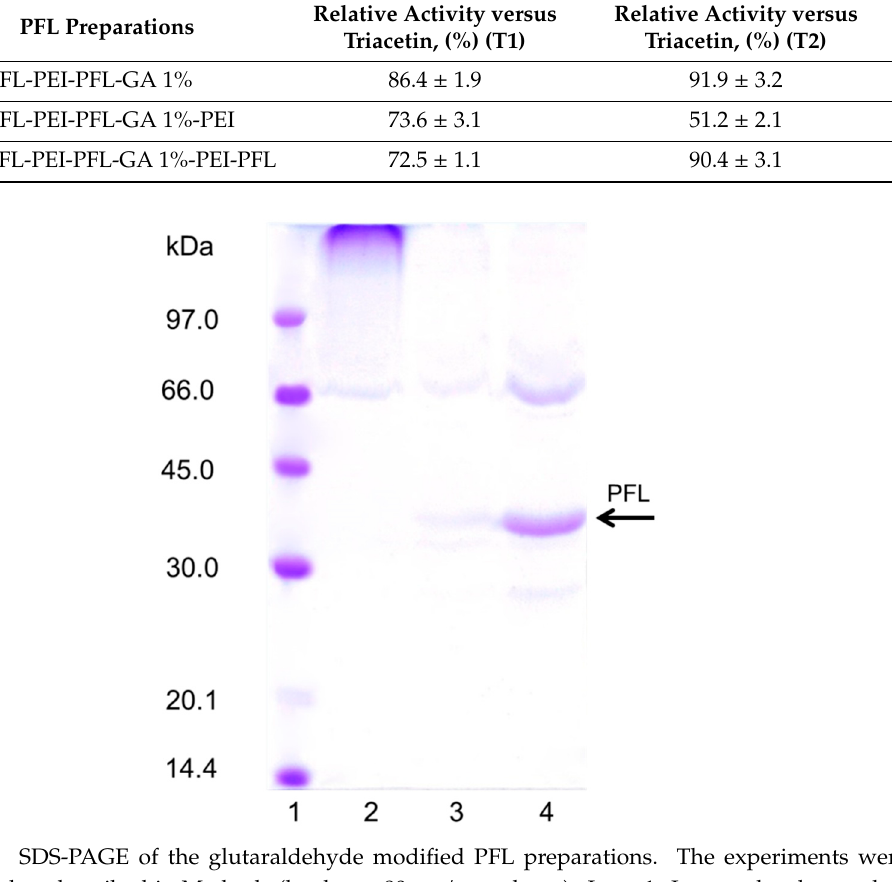
Table 3. Effect of the glutaraldehyde treatment of the PFL biocatalysts on enzyme activity in the hydrolysis of 50 mM triacetin at pH 5. T1: 25 °C. T2: 4 °C in the presence of 30% acetonitrile (v/v). The data are given as relative activity, considering the activity of the respective no treated preparation as 100%. Experiments were performed as described in Methods.